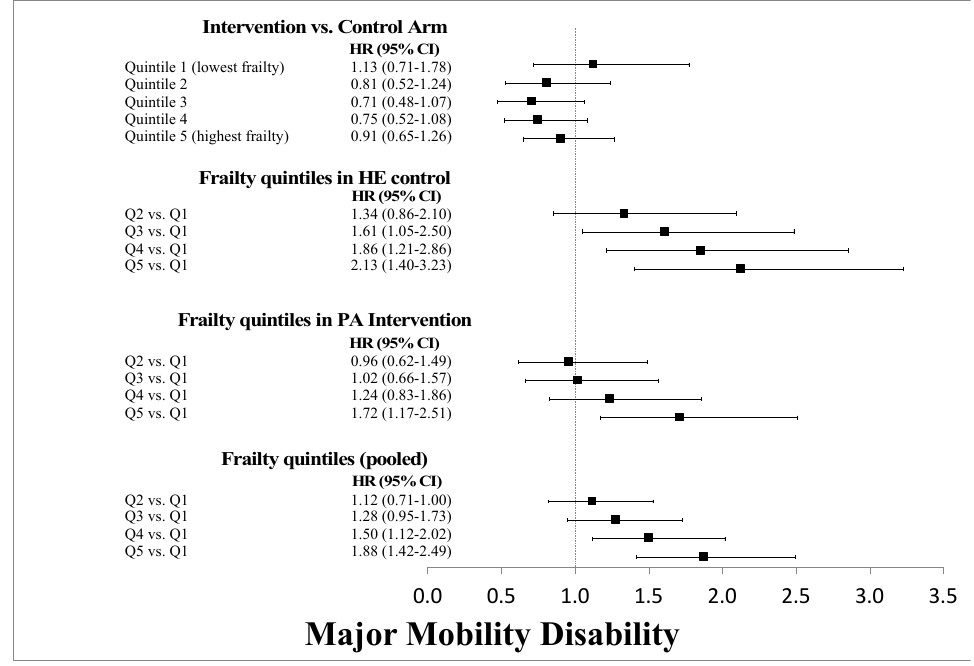
Figure 4. Cox proportional hazard regression results for the interaction between the LIFE Study intervention and quintile stratification of the frailty index for major mobility disability. The topmost results compare the physical activity (PA) intervention versus the health education (HE) control arm stratified by frailty quintiles. The stratified and pooled associations of the quintiles are also shown.